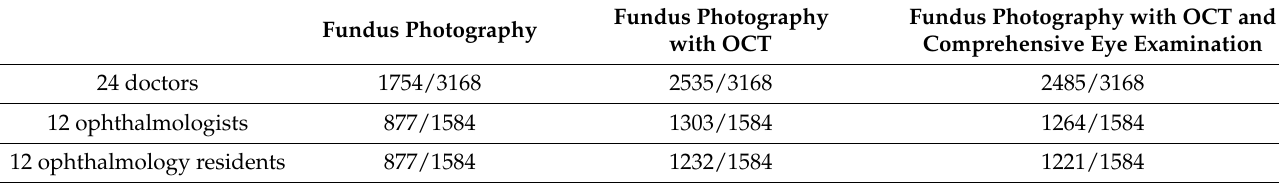
Table 2. Number of diagnosed eyes that required a closer examination (glaucoma or suspected glaucoma) in the three diagnostic strategies/Number of eyes diagnosed with glaucoma.